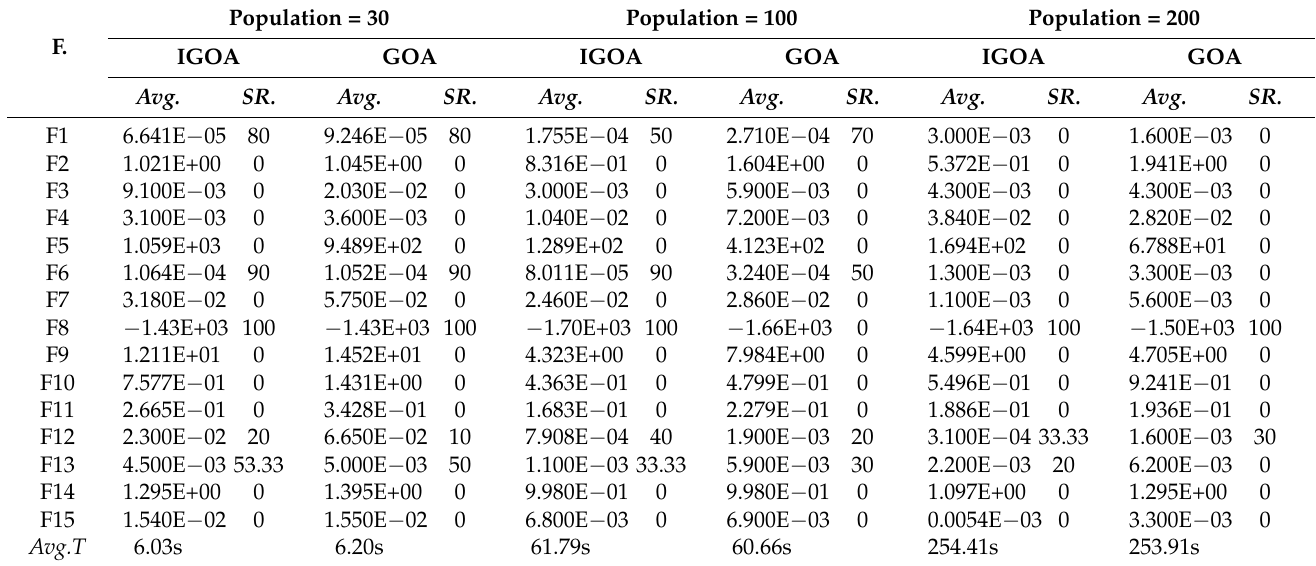
Table 5. The effects of the population size on optimization